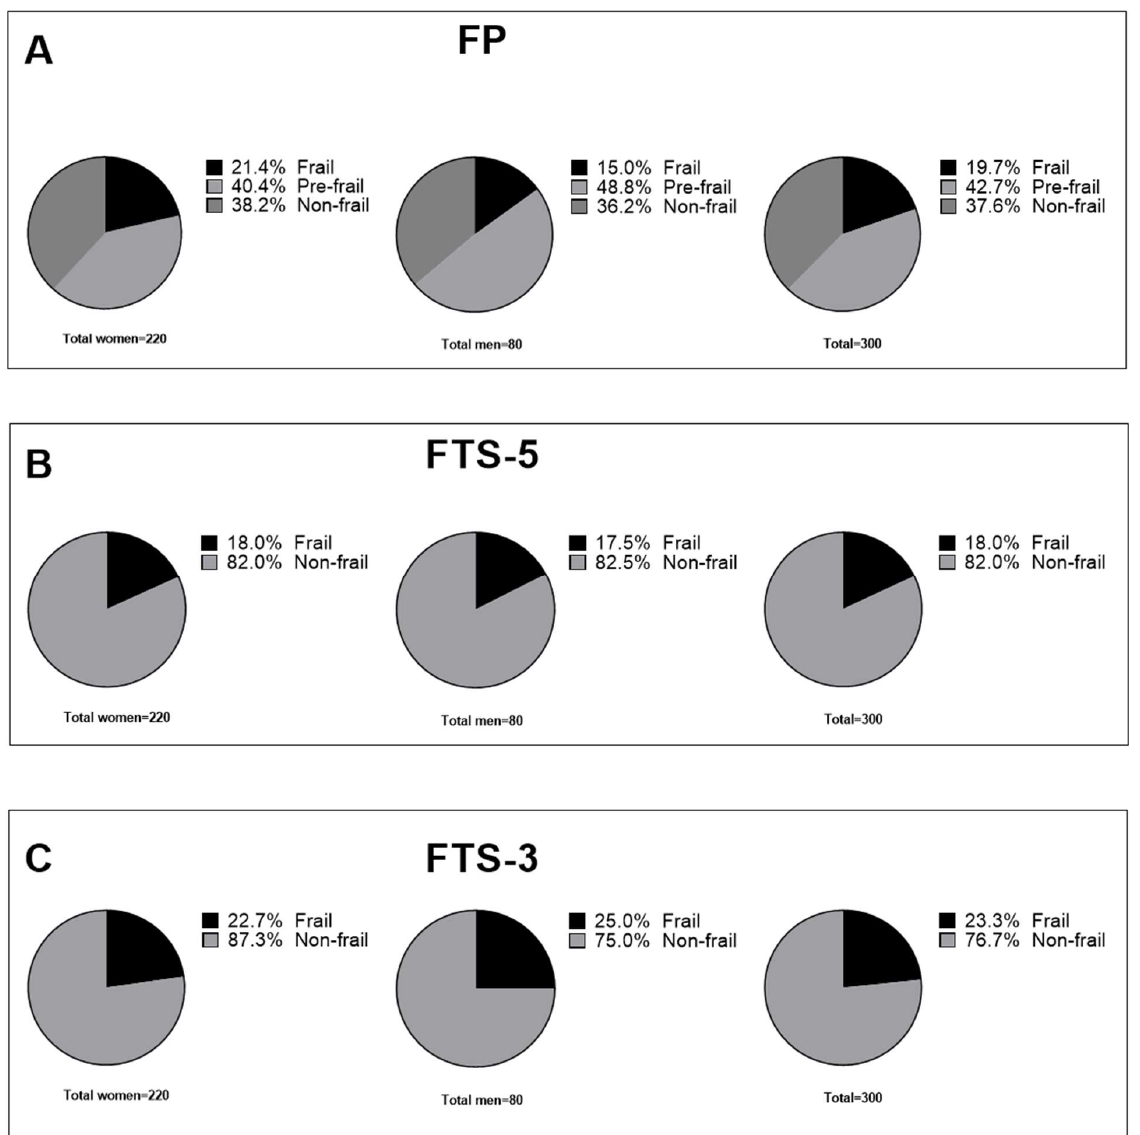
Figure 1. Distribution of frailty syndrome by FP, FTS-5, and FTS-3. ( A ) Distribution of frailty syndrome in women, men, and all participants, according to Fried phenotype. ( B ) Distribution of frailty syndrome in women, men, and all participants according to FTS-5. ( C ) Distribution of frailty syndrome in women, men, and all participants according to FTS-3. FTS-5, Frail Trait Scale 5; FTS-3, Frail Trait Scale 3; FP, Fried Phenotype.